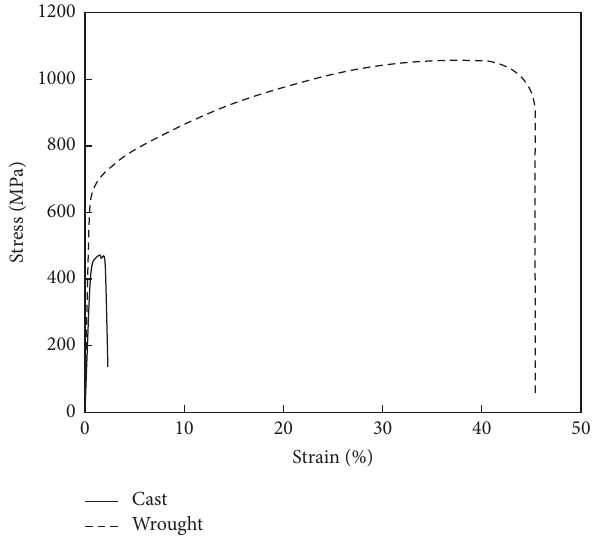
Figure 3: Stress-strain curves of wrought and cast Haynes 282 alloys after room-temperature tensile